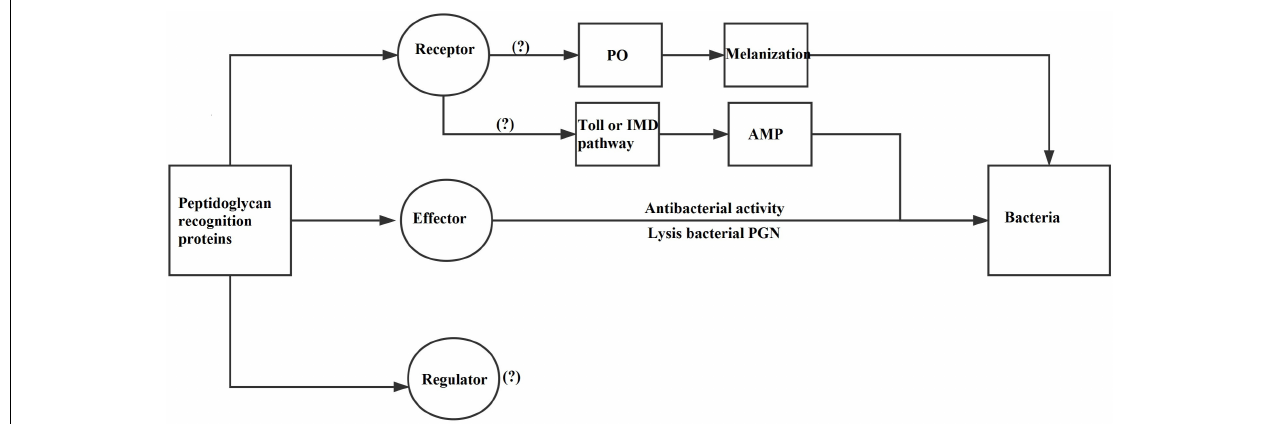
FIGURE 10 | A diagram of PGRPs’ functions [modified from Chen and Lv (2014)]. PO, Phenoloxidase; IMD, Immune Deficiency; AMP, Antimicrobial